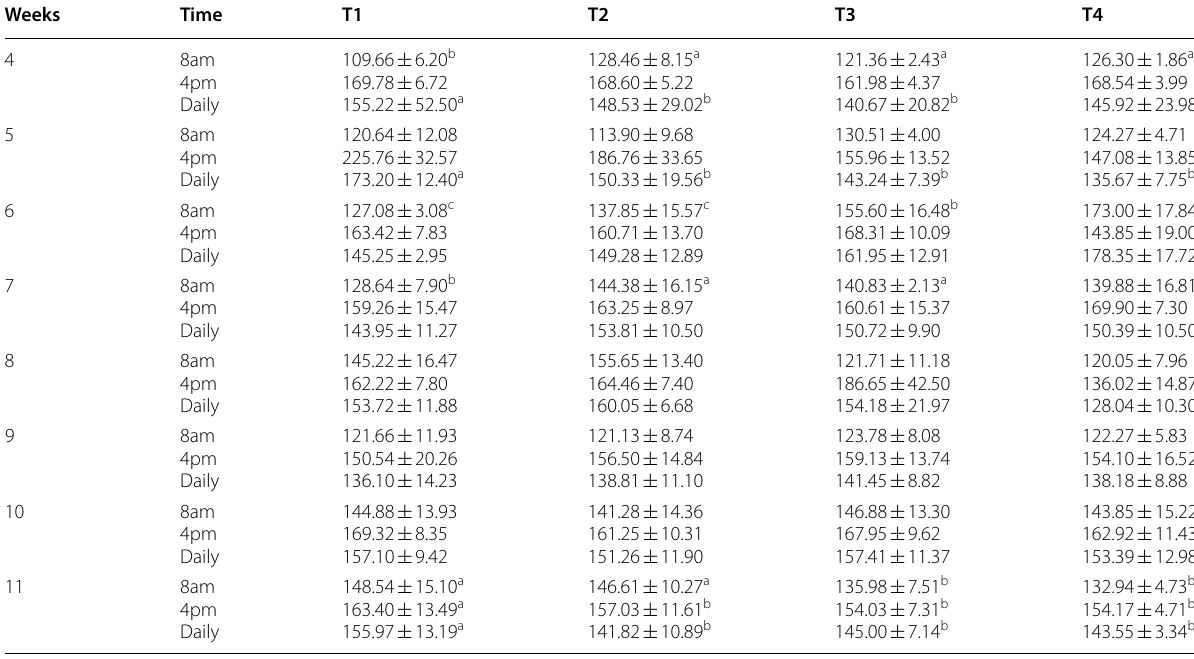
Table 3 Pulse rate (beat/min) of heat-stressed bucks administered ascorbic acid and sodium bicarbonate and their combination